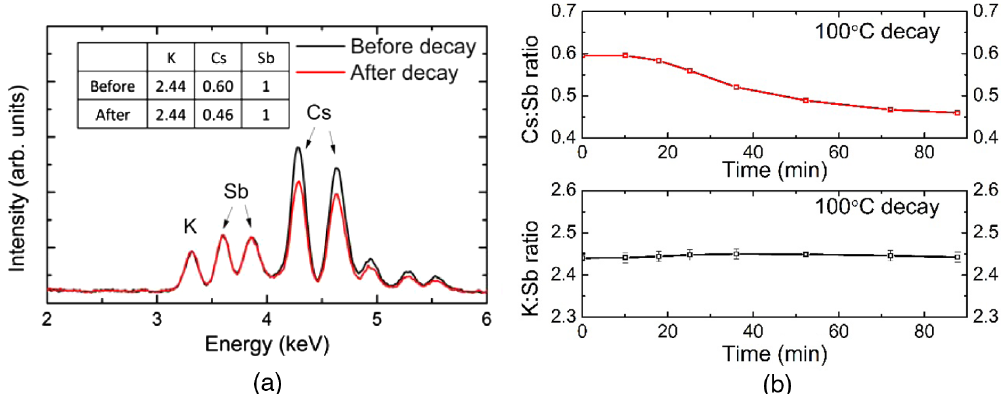
FIG. 4. (a) X-ray fluorescence results of the photocathode before and after the decay, the stoichiometry of the photocathode before and after the decay are shown in the inserted table. (b) Atomic ratio of K to Sb and Cs to Sb during the